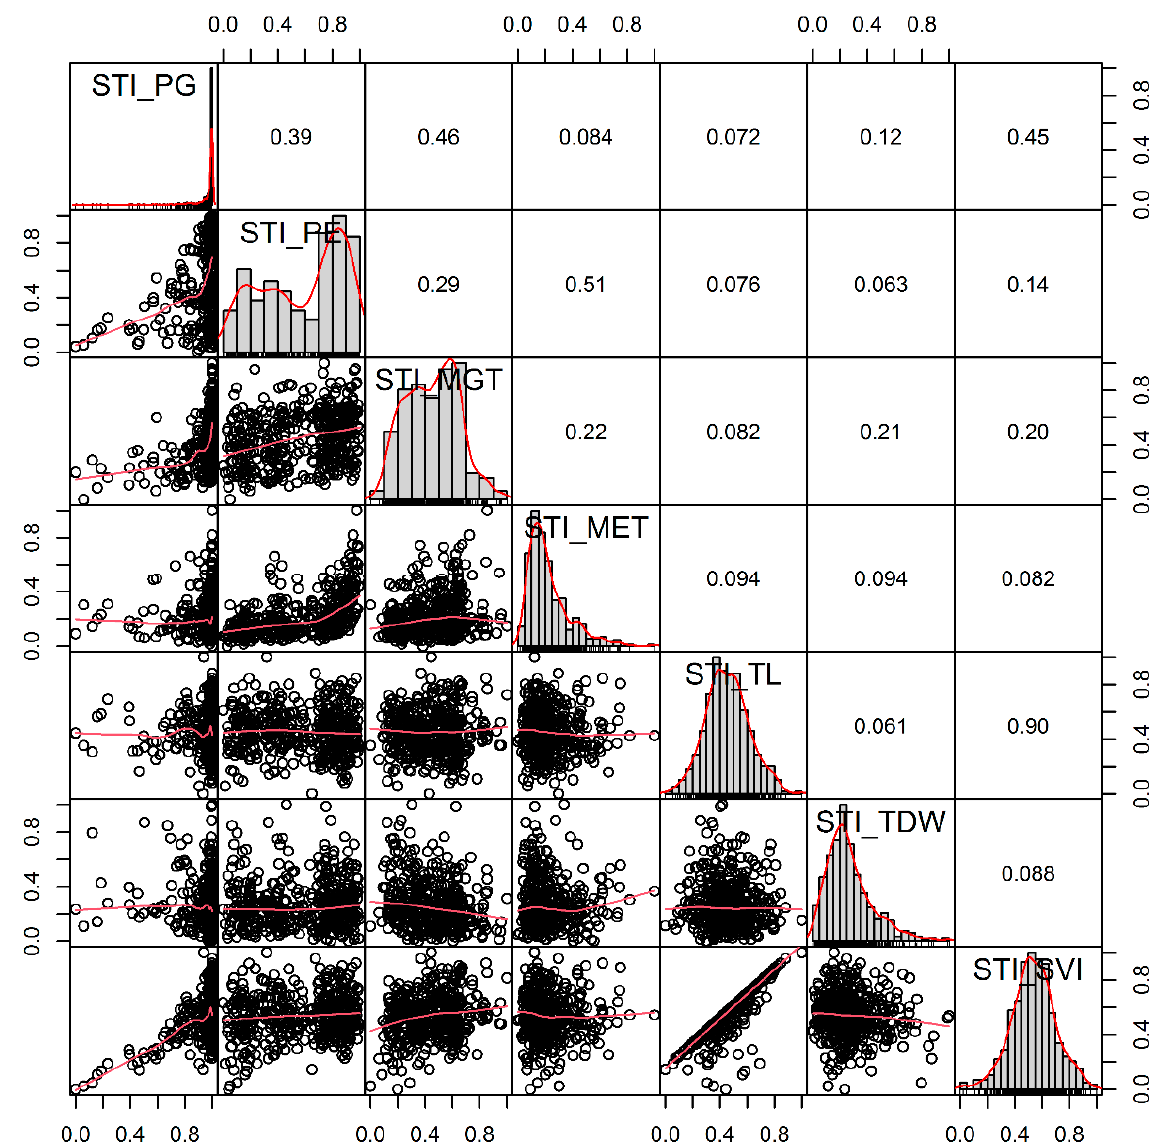
Figure 3. The distributions and distance correlation coefficients of the seed germination- and seedling emergence-related low-temperature tolerance indices. STI_PG, low-temperature stress tolerance index of germination percentage; STI_PE, low-temperature stress tolerance index of emergence percentage; STI_MGT, low-temperature stress tolerance index of mean germination time; STI_MET, low-temperature stress tolerance index of mean emergence time; STI_TDW, low-temperature stress tolerance index of total dry weight; STI_TL, low-temperature stress tolerance index of total seedling length; STI_SVI, low-temperature stress tolerance index of seedling vigor index.